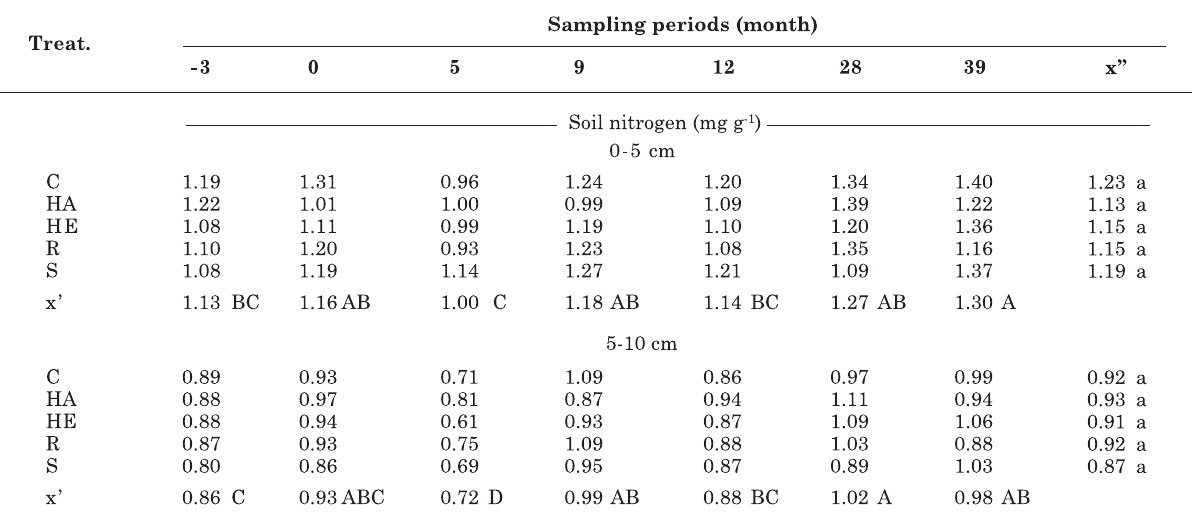
(1) Fertilization applied in month 0, after soil sampling. C: control; HA: harrowing, HE: herbicide, R: rice and S: soybean. n: 4; x ’ : means of sampling periods, x’’: treatment mean. n: 4. Means followed by the same letter or without letters are not statistically different by the Tukey test at 5 %. Lowercase letters compare means in columns and capital letters means in the rows. For the 0-5 cm layer: CV = 12.81, F_treat = 2.03 ns, F_time = 8.57 **, F_treat * time = 1.60 ns; for 5-10 cm : CV = 12.74, F_treat = 0.51 ns; F_time = 15.69**, F_treat * time = 1.52